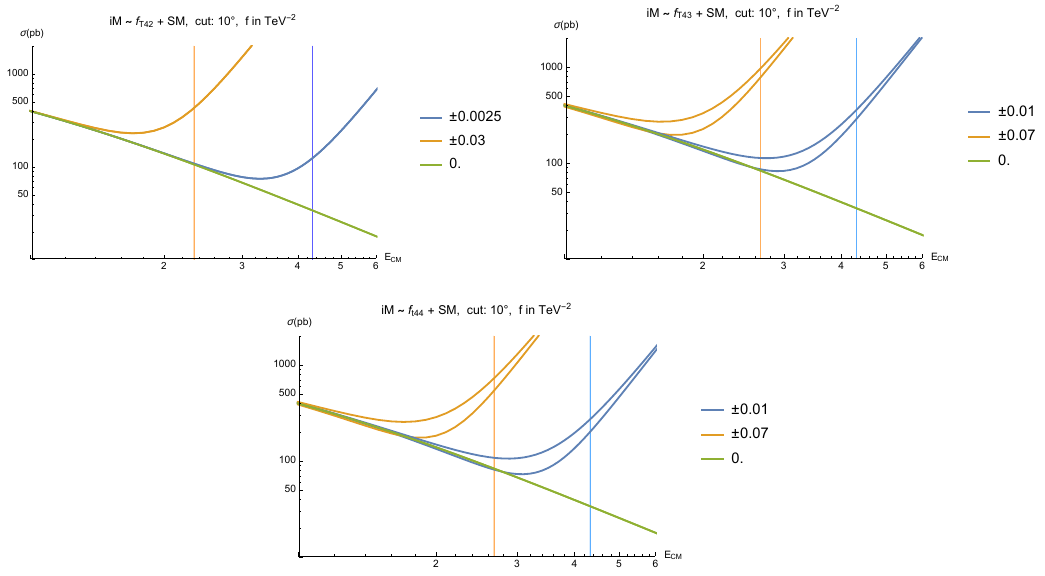
Figure 6 . Energy dependence of the total unpolarized W + W + cross sections ( E TeV) for a chosen set of f dence). There is no color distinction between the signs: for both section curves correspond to f